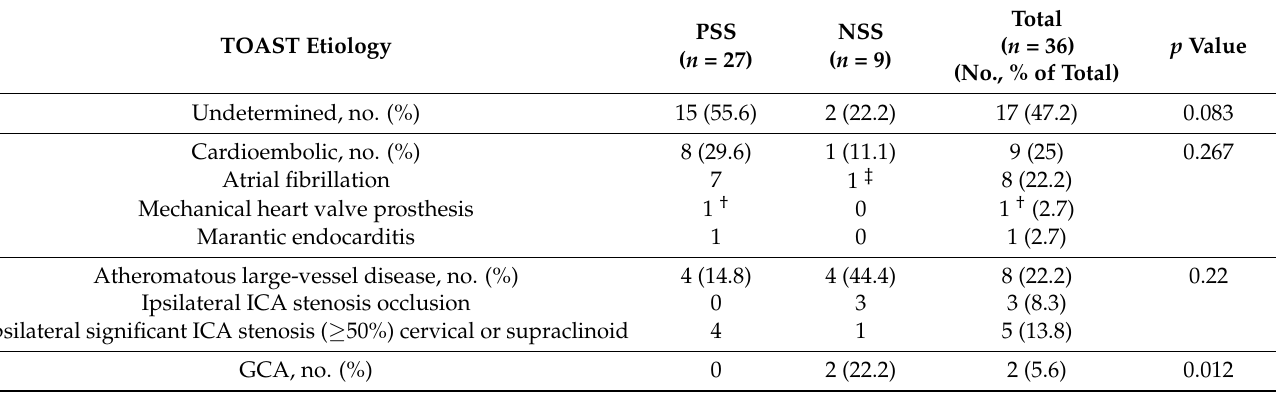
Table 3. CRAO etiology by TOAST classification.